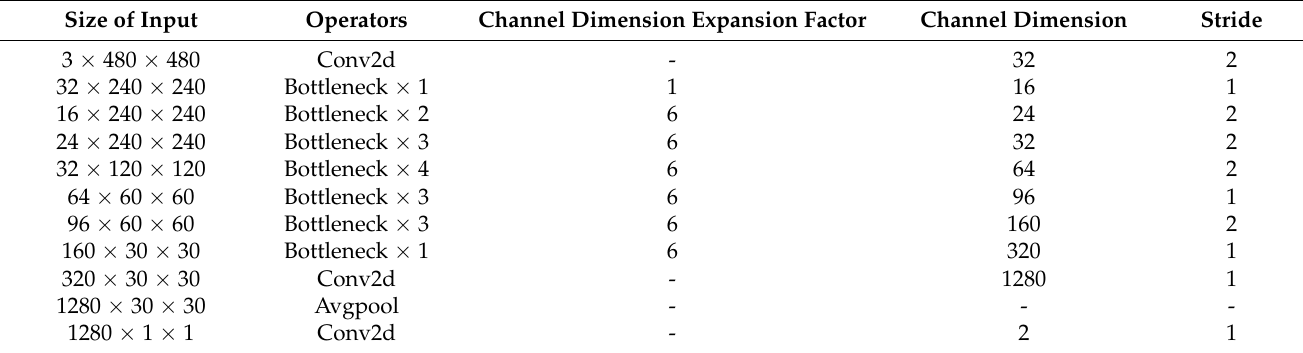
Table 2. Specific parameter list of mobilenetv2